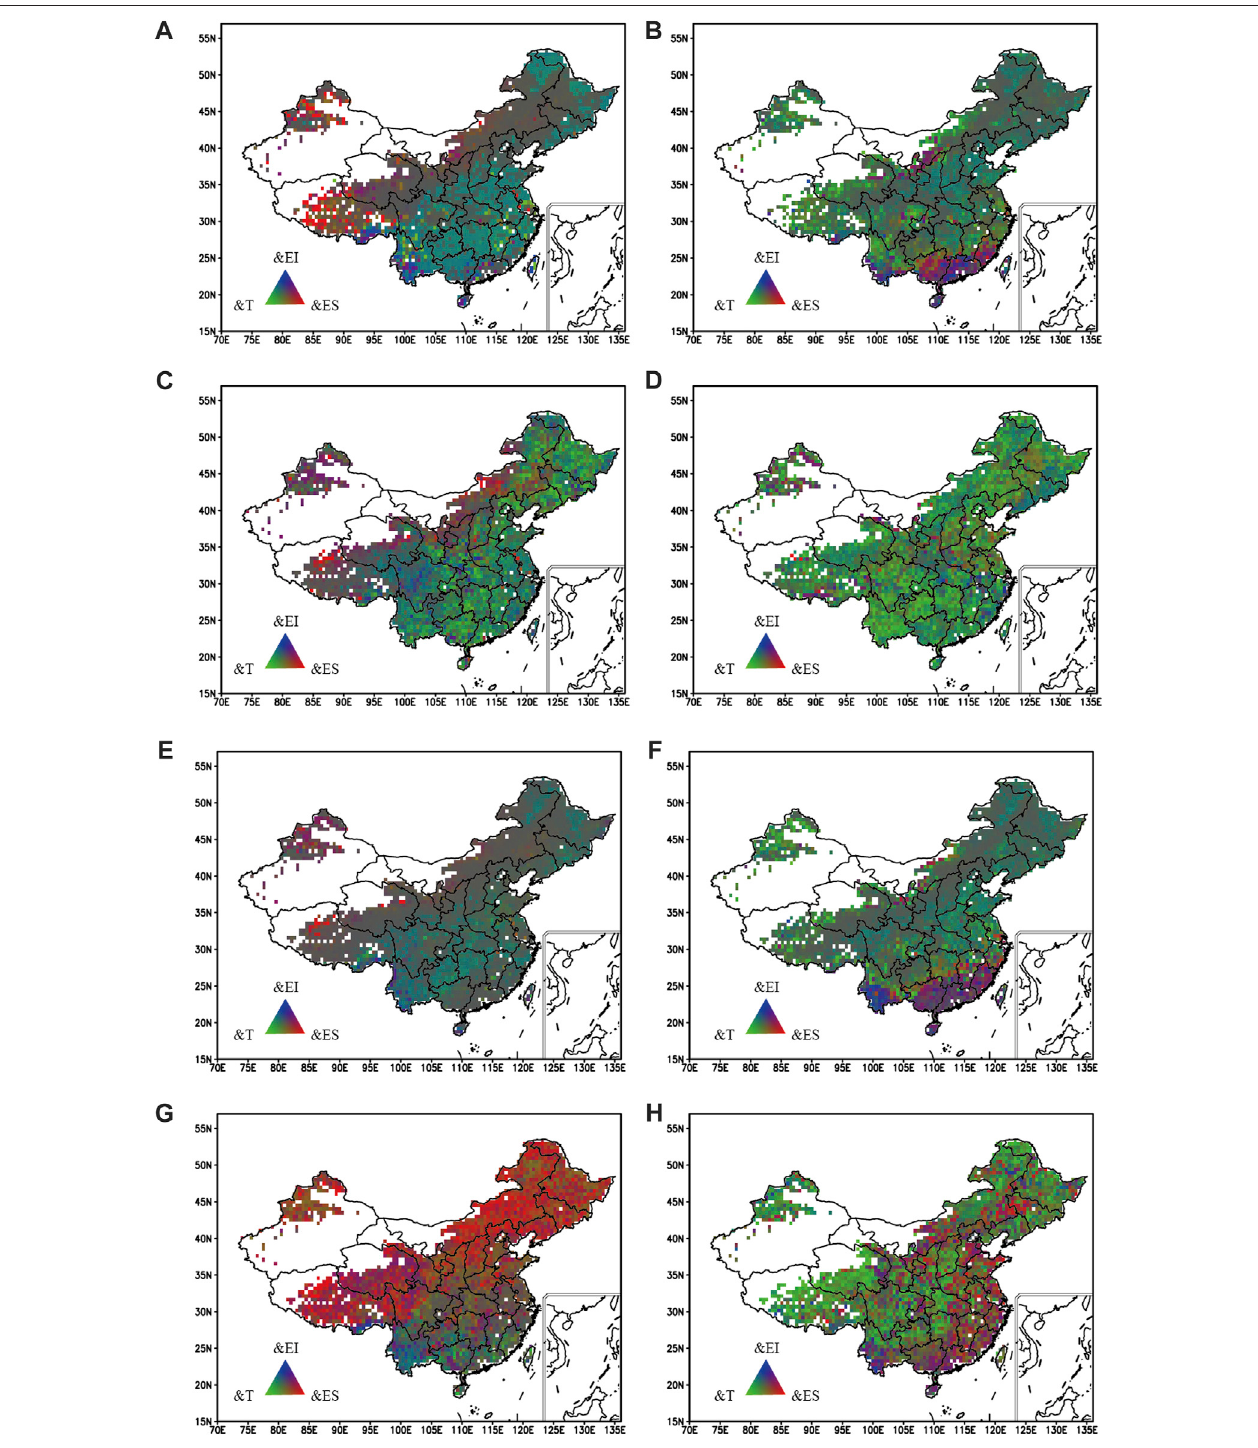
FIGURE 7 | The spatial contribution of transpiration (&T), canopy interception (&EI), and soil evaporation (&ES) on ET and T/ET anomalies. Each color corresponds toauniquecombinationofthecorrelationcoef fi cientsofthethreecomponentswithET (A – G) andT/ET (B – H) .The fi rstcolumnisETandthesecondisT/ET.Spring (A,B) summer (C,D) autumn (E,F) and winter (G,H) .